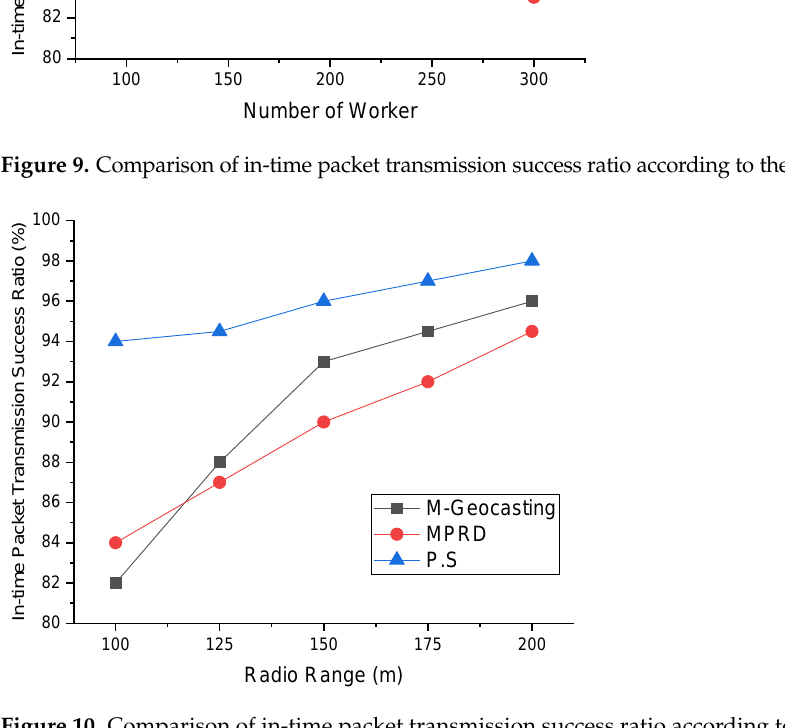
Figure 10. Comparison of in-time packet transmission success ratio according to the radio